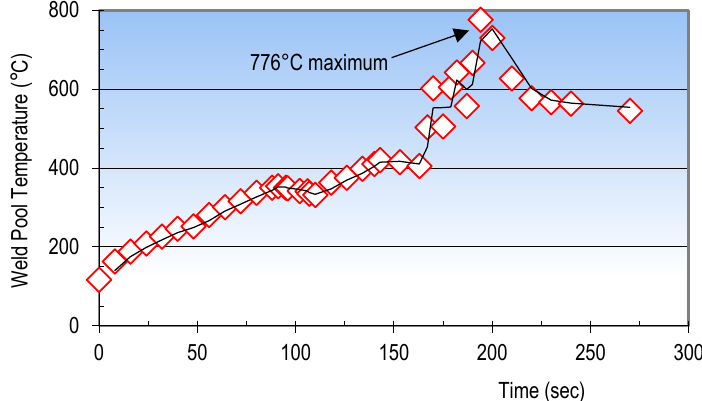
Figure 5: Finite element simulation of weld pool temperature. Preheating to 150°C, left heating 0-95 sec, idle 95-110 sec, right heating 110-145 sec, idle 145-165 sec, welding 165-195 sec at 90 A, cooling after 195